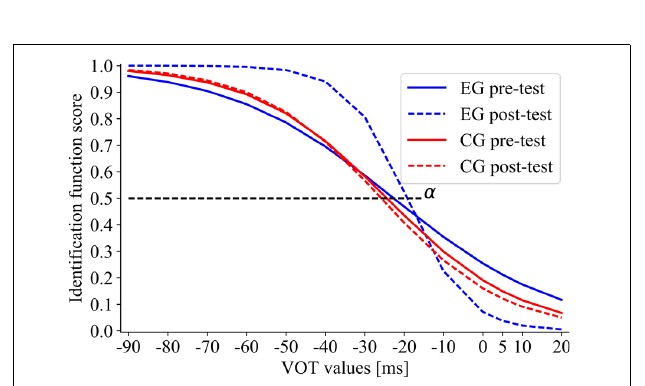
FIGURE 7 | The sigmoid function for EG and CG subgroups in pre- and post-test performance. The boundary location ( α ) corresponds to the VOT value at which 50% of voiced/unvoiced identifications were detected.